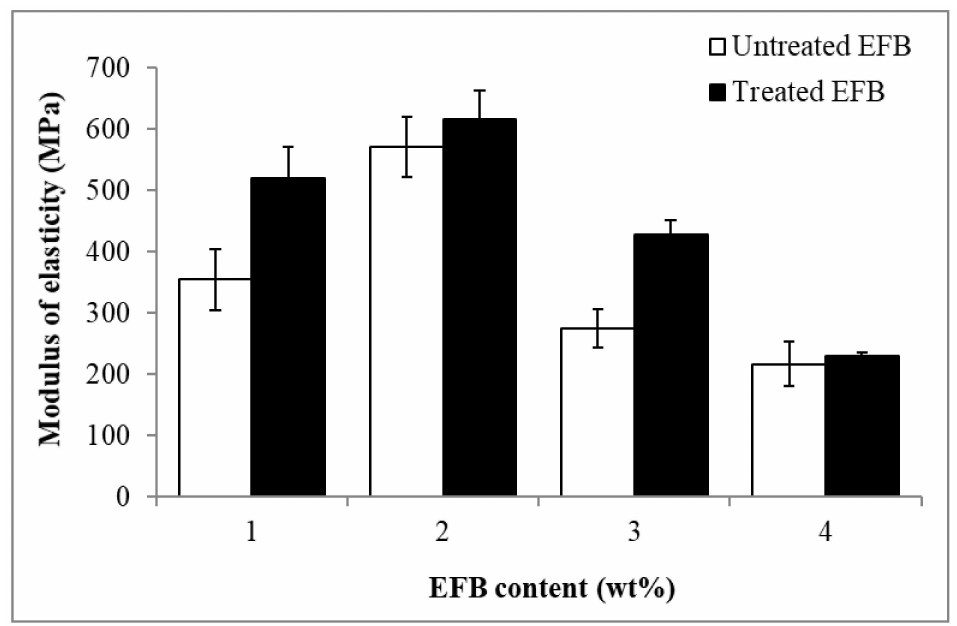
Figure 4. E ff ect of EFB content on modulus of elasticity of untreated and MMA-treated EFB RC biocomposite films.